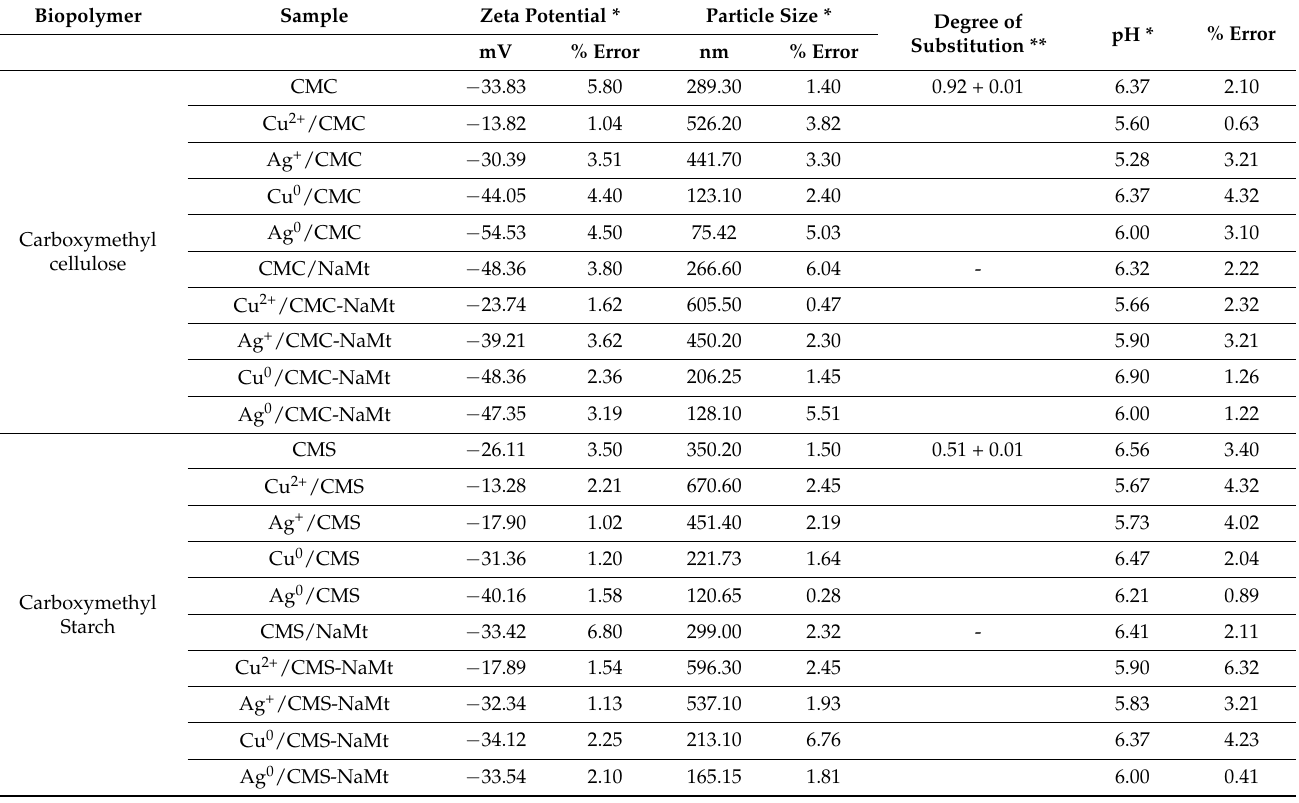
Table 1. Some physical–chemical features of the investigated